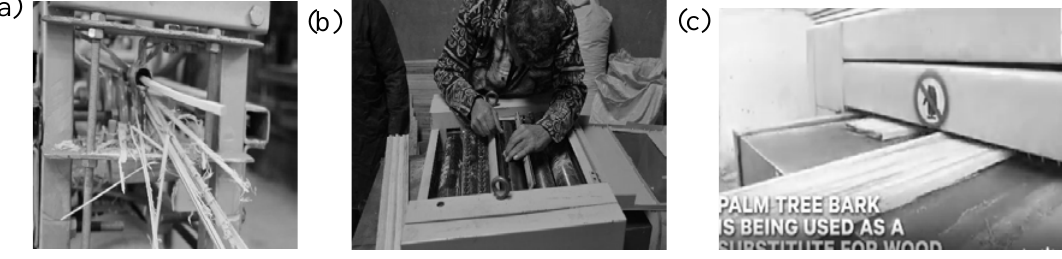
Figure 6. Photographs of (a) Cutting process, (b) Trimming process (c) Collect and Compress